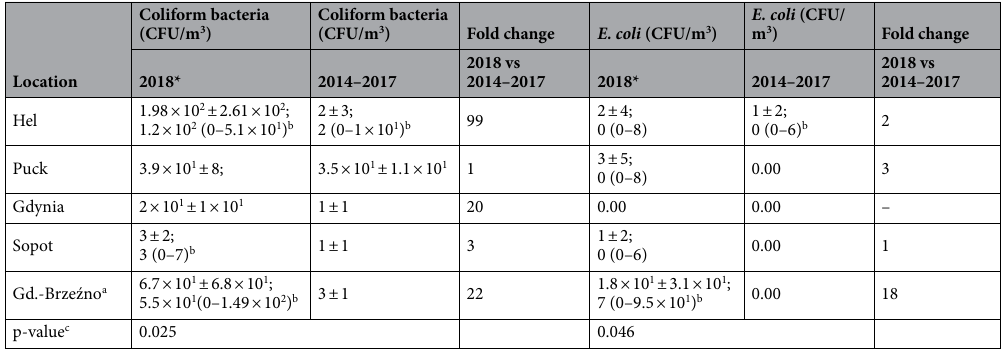
Table 5. The mean and standard deviation ofconcentration of coliforms and E. coli (CFU/m 3 ) in air over the Bay of Gdańsk in 2018 versus 2014–2017. a Gd.-Brzeźno—it is an abbreviation of the town name Gdańsk- Brzeźno, b in case of a higher standard deviation than the mean, the median and range (min–max) was calculated, c Friedman test, α-0.05, *The results marked in grey colour have been published in preliminary study 36